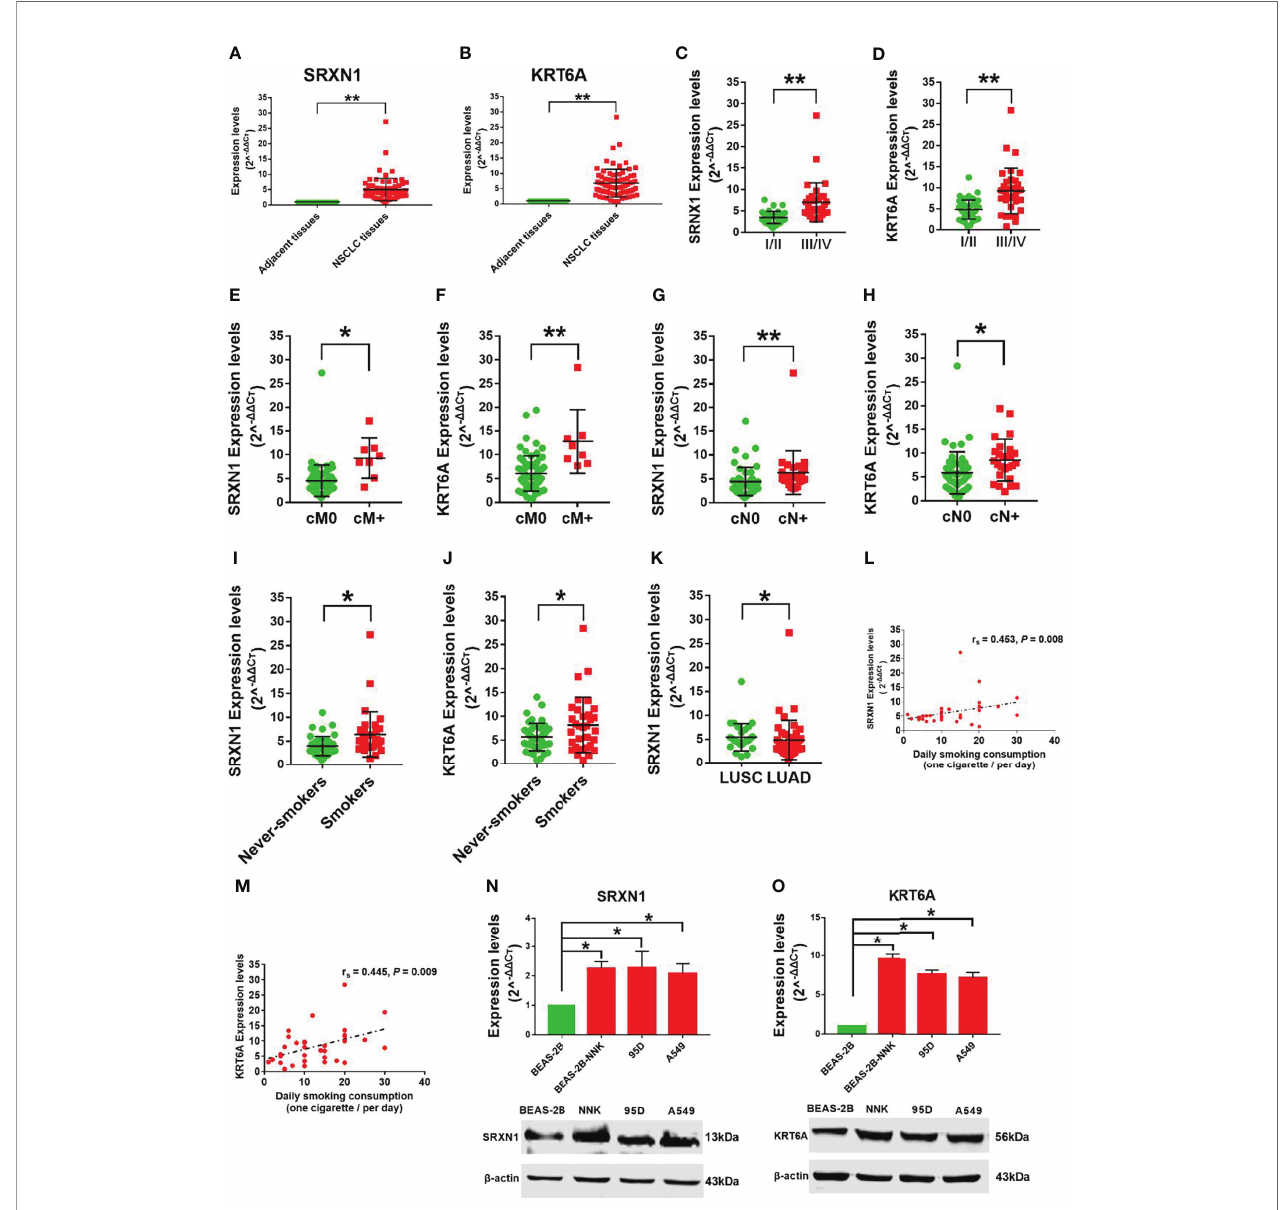
FIGURE 4 | Strong expression of SRXN1 and KRT6A in non-small-cell lung cancer (NSCLC) tissues and lung cancer cell lines. (A) SRXN1 expression was detected in NSCLC and normal tissues by RT-qPCR. (B) KRT6A expression was detected in NSCLC and normal tissues by RT-qPCR. (C, D) Higher expression of SRXN1 and KRT6A in patients with clinical stage III/IV NSCLC vs. those with clinical stage I/II NSCLC. (E, F) Higher expression of SRXN1 and KRT6A in patients with cM+ NSCLC vs. patients with cM0 NSCLC. (G, H) Higher expression of SRXN1 and KRT6A in patients with cN+ NSCLC vs. patients with cN0 NSCLC. (I, J) Higher expression of SRXN1 and KRT6A in smokers with NSCLC vs. never-smokers with NSCLC. (K) Higher expression of SRXN1 in LUAD patients vs. LUSC patients. (L, M) Scatter plots of the correlations between SRXN1 and KRT6A expression and daily smoking consumption. (N, O) RT-qPCR and western blot analyses of the SRXN1 and KRT6A mRNA and protein levels in 95D, A549 and Beas-2B-NNK cells vs. with Beas-2B cells. * P < 0.05, ** P <